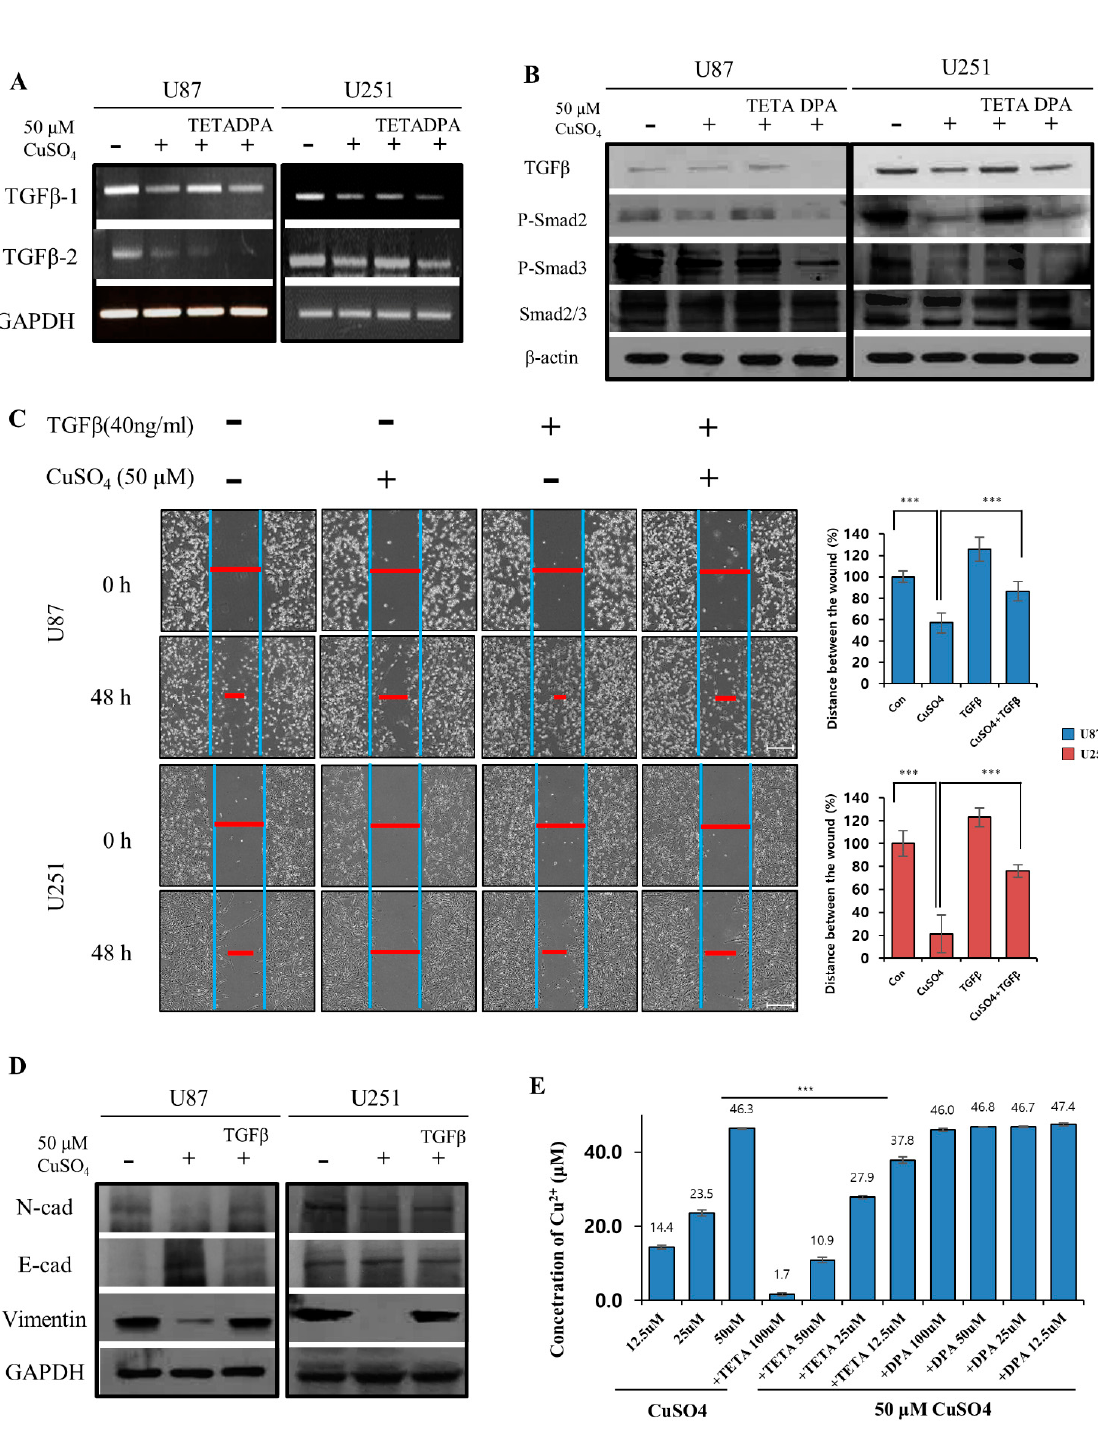
Figure 4. ( A ) The transcriptional levels of TGF- β 1 and TGF- β 2 compared with cells treated with CuSO 4 and chelators using RT-PCR. ( B ) The effect of copper with chelators on TGF- β /Smad signaling in GBM cells evaluated by Western blotting assay. ( C ) Wound healing assays of absence or presence of 40 ng/mL TGF- β 1 in 50 µ M CuSO 4 and images obtained at 48 h. Scale bars: 200 µ m. ( D ) The expression of EMT regulators in GBM cells evaluated using Western blot assay. ( E ) Measurement of a copper concentration treated with 50 µ M CuSO 4 with various concentrations of chelators using a copper assay kit. Data represent mean ± SD of three independent experiments using two-tailed t -test. *** p <